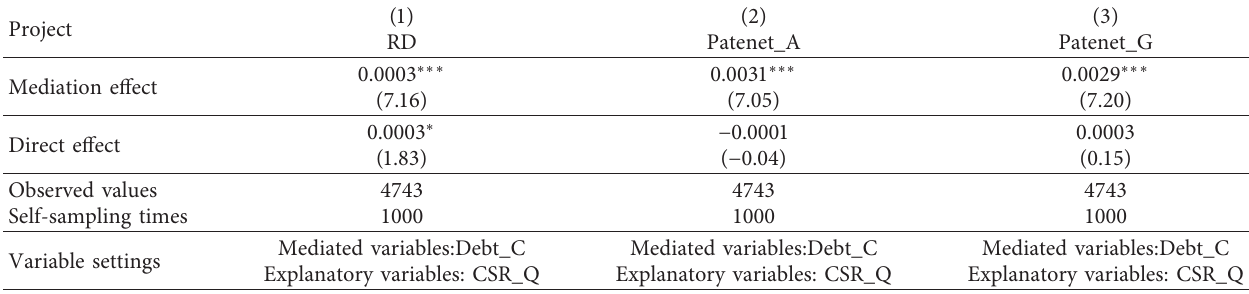
Table 14: Bootstrap mediated effect